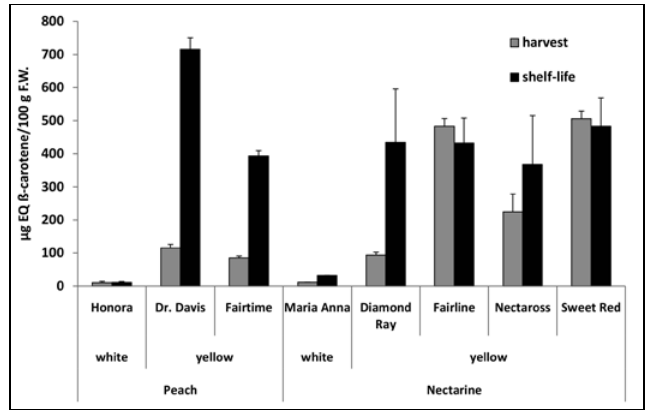
Fig. 1 - Total carotenoids content of the flesh of peach and nectarine cultivars at harvest and after five days of shelf-life at 20°C. Bars refer to standard